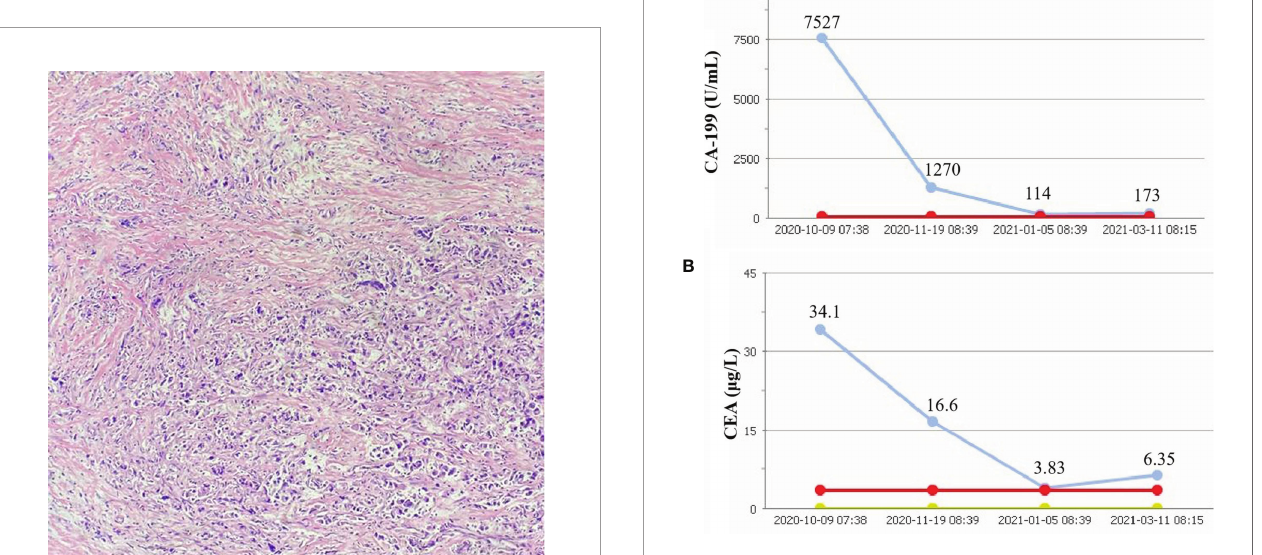
FIGURE 1 | Pathology results. H&E staining of the biopsy specimen showed poorly differentiated adenocarcinoma.